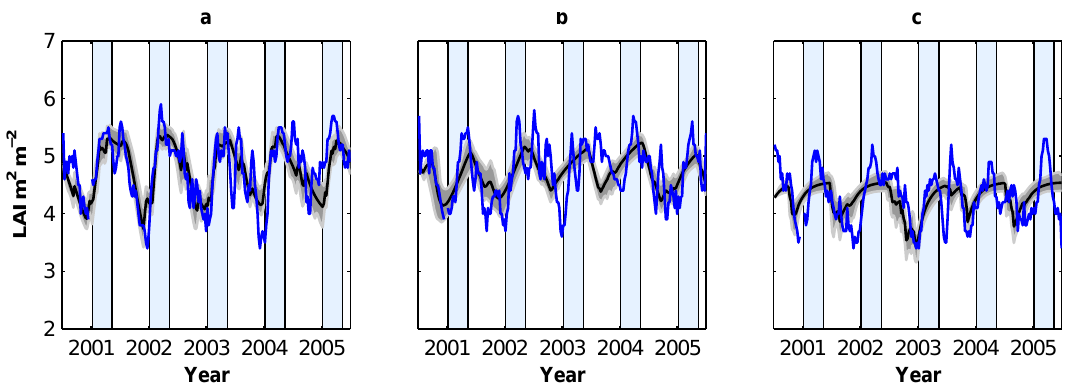
Fig. 4. LAI time series in (a) the eastern Amazon (8 ◦ N 62.5 ◦ W), (b) the semi-deciduous Amazon (0 ◦ N 72.5 ◦ W), and (c) the evergreen central Amazon basin (4 ◦ N 67.5 ◦ W), as predicted by the model (black line) and MODIS LAI data (blue line). Gray shaded area represents 95% confidence intervals. Blue bands represent aproximate dry seasons.